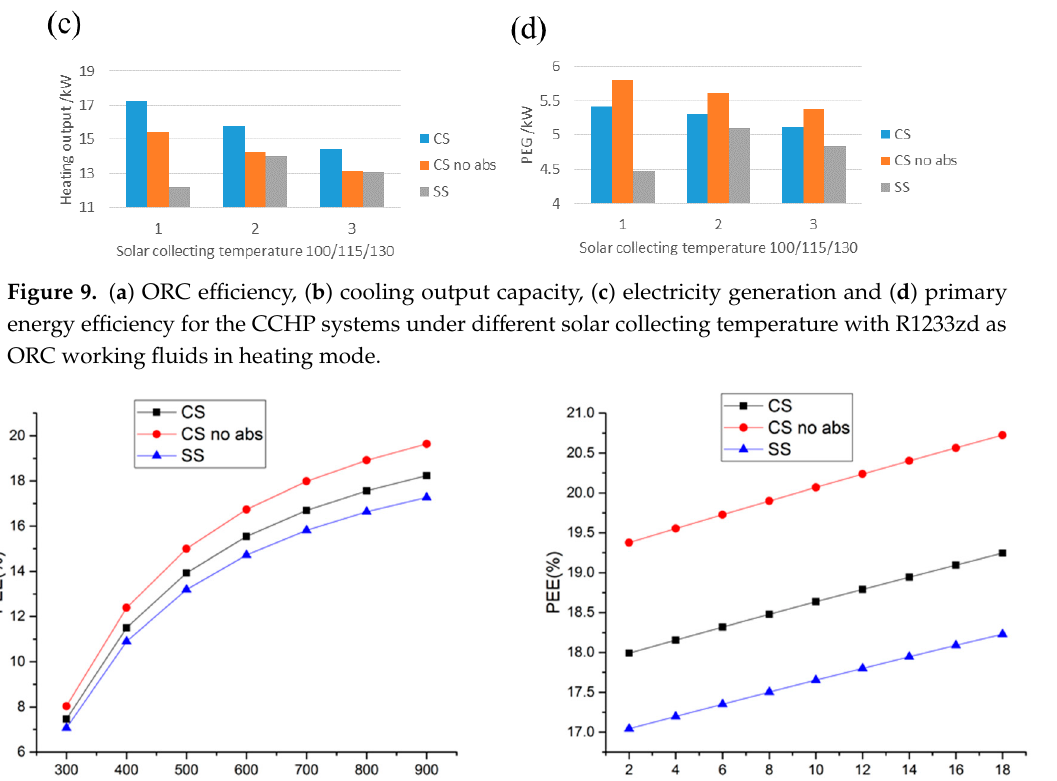
Figure 10. PEE of the systems as a function of solar radiation and ambient temperature.